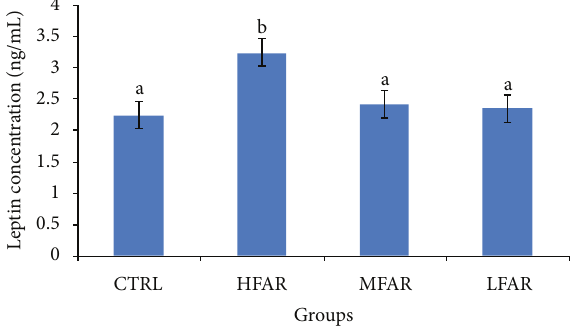
Figure 1: Plasma leptin concentration of rats in the four treatment groups. a , b Different letters among groups indicate significant differ- ence at 𝑃 < 0.05